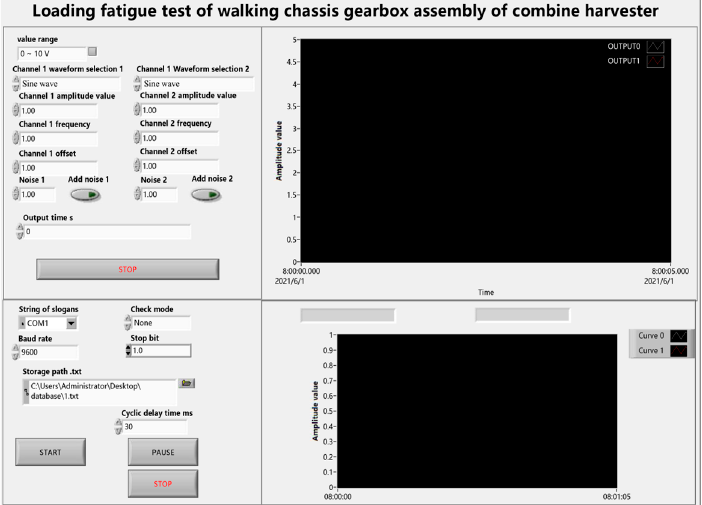
Figure 6. Program control interface. Table 4. Schedule of shifts.